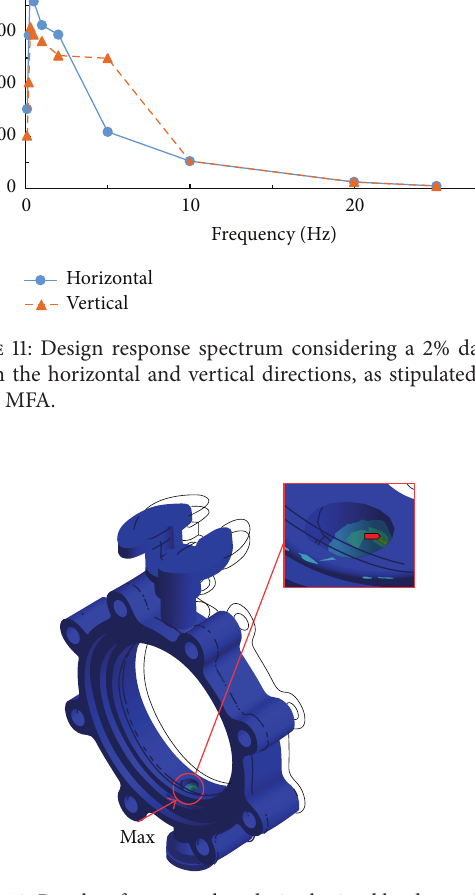
Figure 12: Results of structural analysis obtained by dynamic anal-